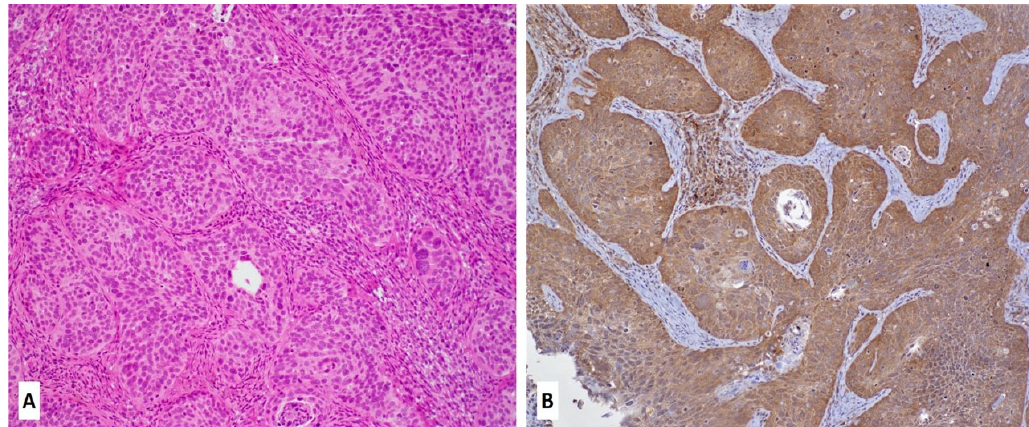
Figure 2. Fascin expression in cervical cancer ( A , B ). A case of invasive squamous cell carcinoma of the uterine cervix: ( A ) hematoxylin and eosin slide (20 × ) with diffused and strong immunohistochemical expression of the fascin protein in cancer cells ( B , 20 ×